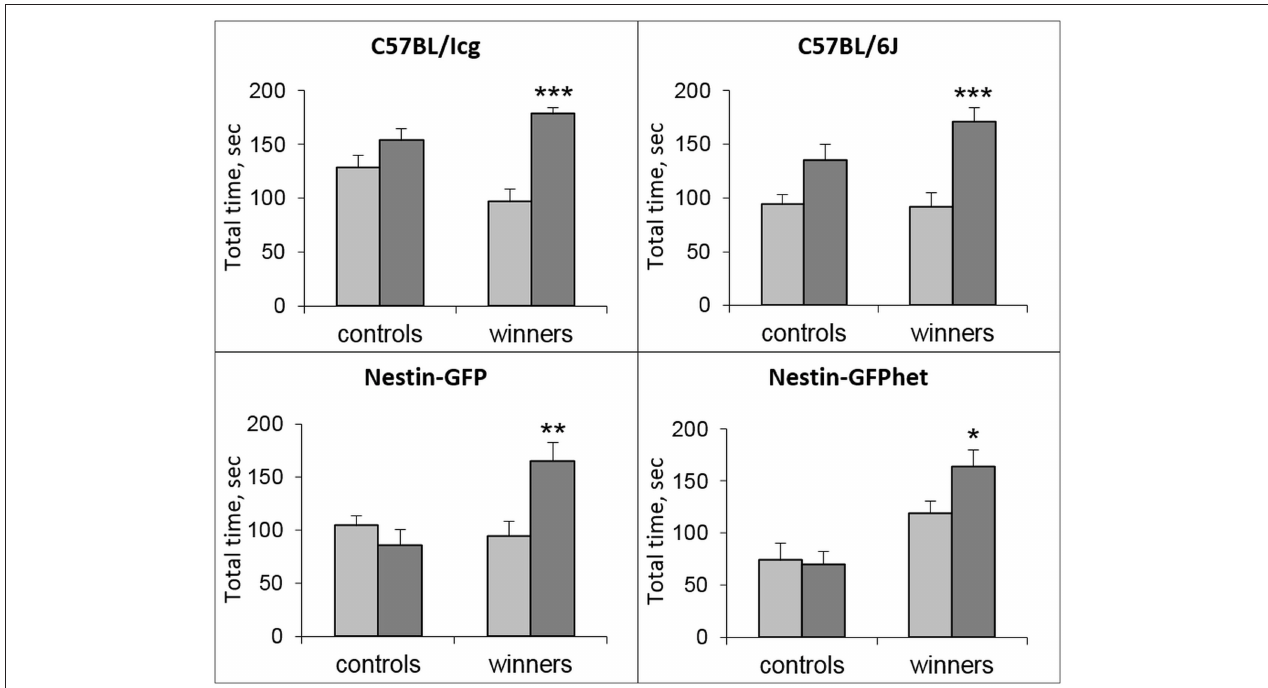
FIGURE 1 | Partition test for male mice of different lines. Total time spent near the partition by the male mice of four lines (see captions) in the control and Win-21 groups as reaction to the familiar (light bars) and unfamiliar (dark bars) partners in the neighboring compartment of the common cage. * P < 0.05 , ** P < 0.01 , *** P < 0.001 ; paired t -test for unfamiliar vs. familiar partner.